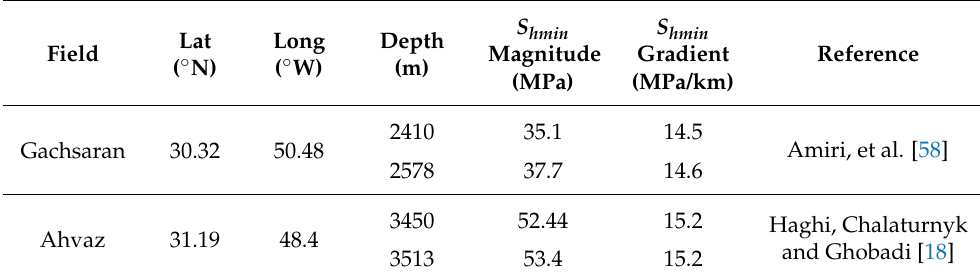
Table 2. Summary of the leak-off test results reported for the Dezful Embayment.